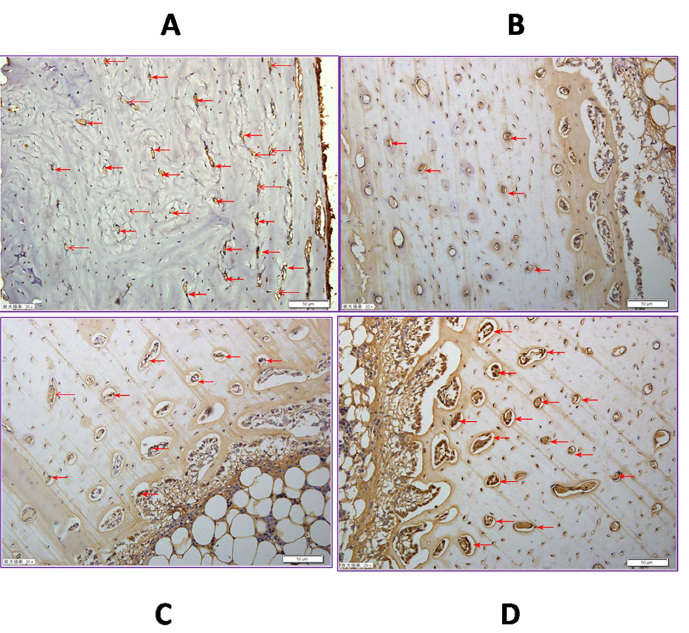
Fig 3. Substance P semi quantitation of left tibia 4 weeks post treatment. SP staining is shown in brown (red arrow). Scale bar = 50 μ m.Values are means ± SD of six rabbits in each group. A . SP in sham groups were higherthan all others ( p < 0.05); B . SP in SNCr group was less than all others ( p < 0.05); C .SP in treadmill group was higherthan SNCr group ( p < 0.05), less than ET group ( p < 0.05); D . SP in ET group was higherthan other groups( p < 0.05),except sham groups, was lower than sham groups( p <